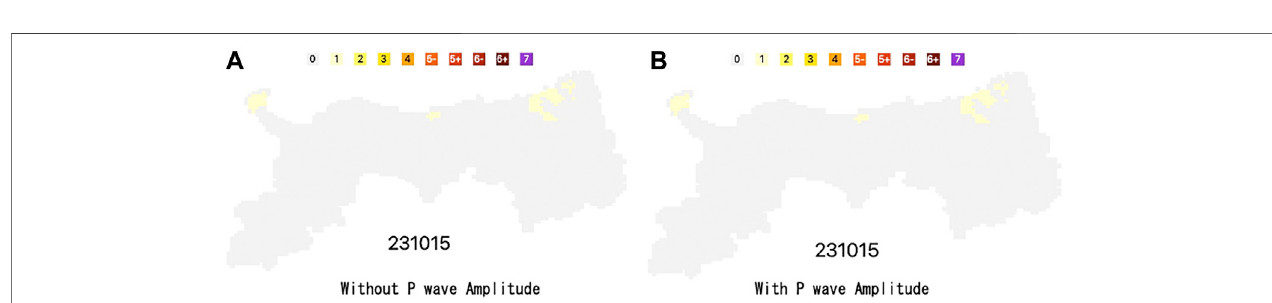
Frontiers in Earth Science |